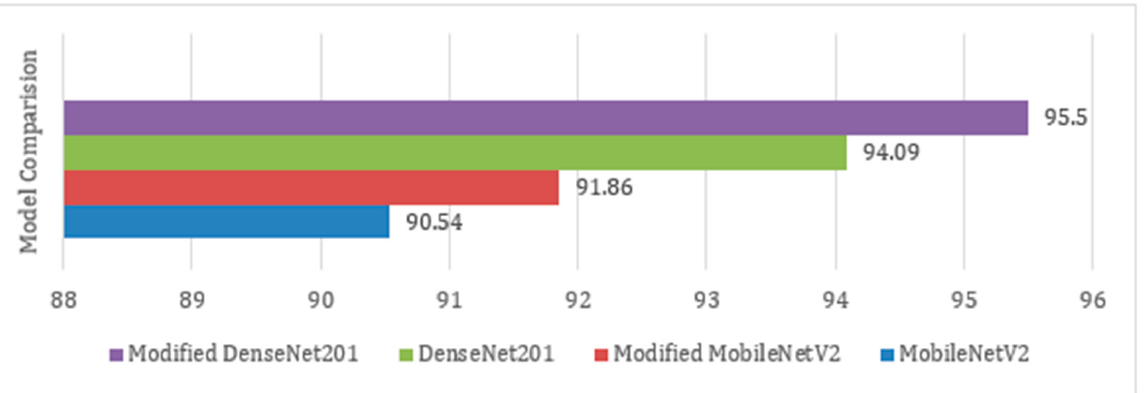
Figure 12. Performance comparison of the four models used in this work. Table 5. Comparison with state of the art techniques.